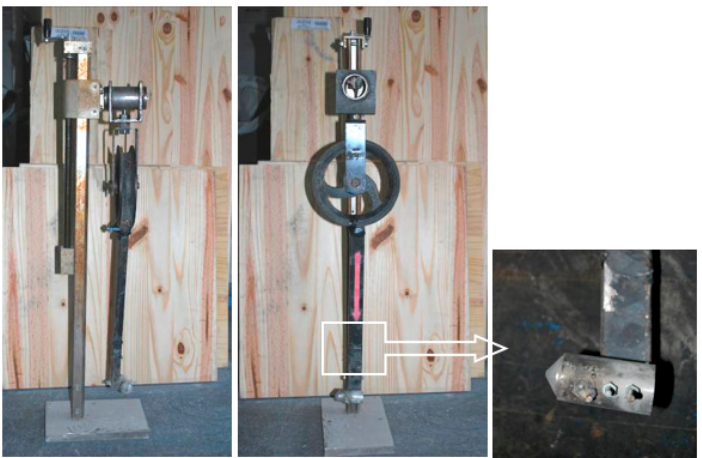
Figure 4. Initial prototype and pick employed.